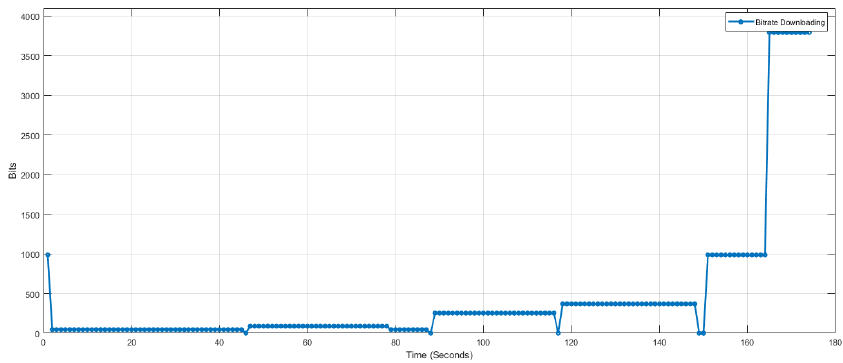
Figure 6. Results of bit rate downloading network feature experimentation